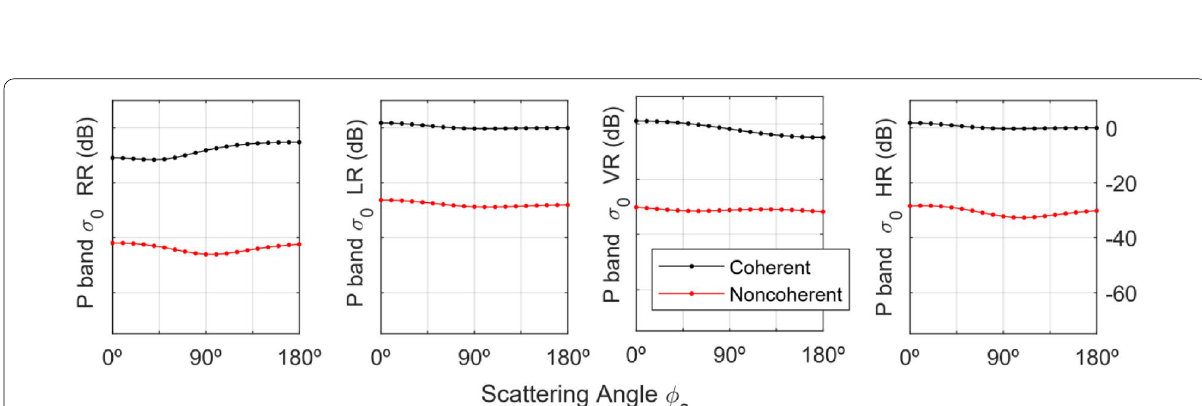
Fig. 9 Coherent and non-coherent parts of the scattering for different polarizations. The geometry for the coherent scattering is θ i ranges from 0° to 180°. For the non-coherent scattering, the geometry is θ